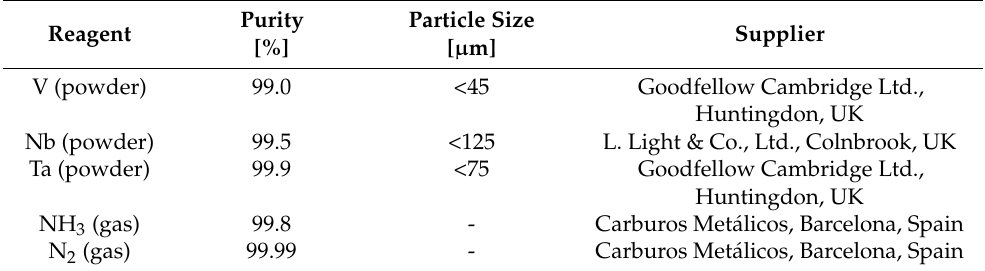
Table 1. Specifications of reagents used.